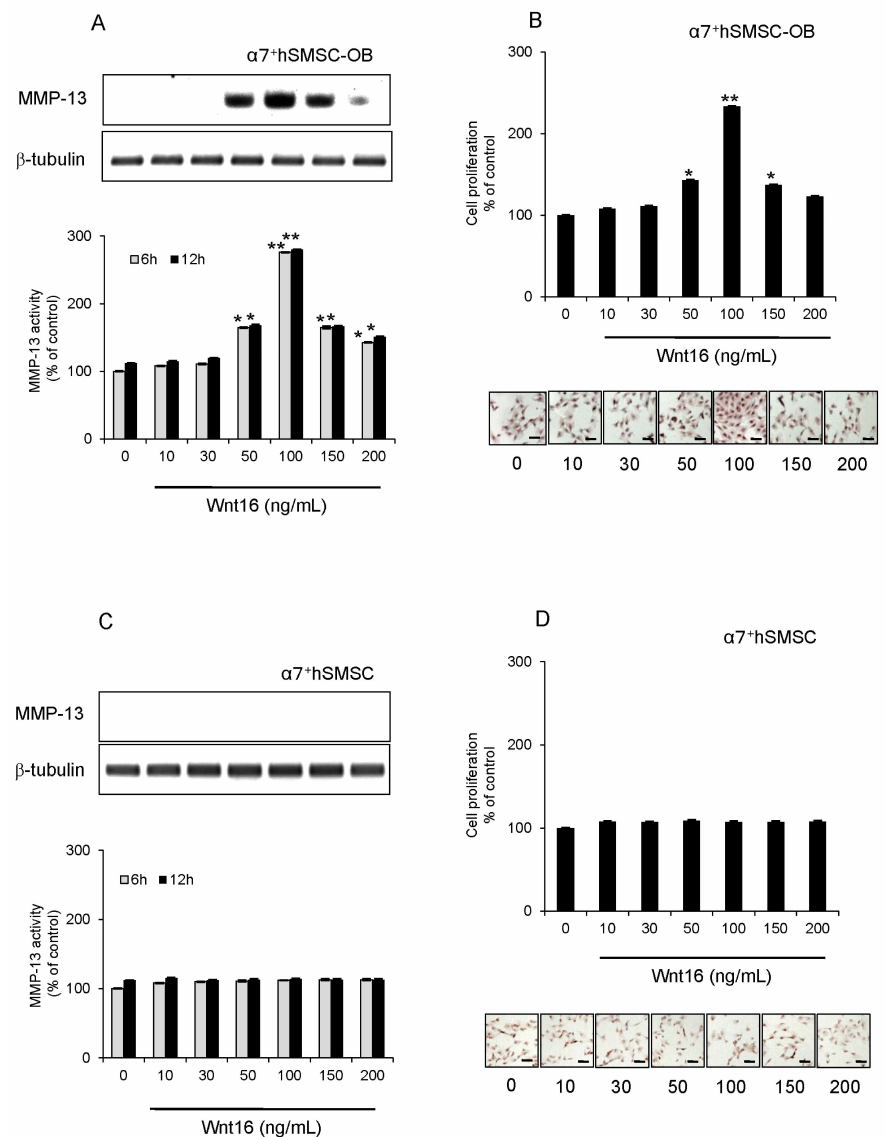
Figure 3. Effect of exogenous Wnt16 on MMP-13 expression and activity, and the proliferation of α 7 + hSMSC-OB cells. ( A , B ) Cells were treated for 6 h (grey bars) and 12 h (black bars) with 0, 10, 30, 50, 100, 150 and 200 ng/mL exogenous Wnt16 prior to analysis. Upper panels show Western blots of MMP-13 protein expression compared with β -tubulin levels. Blots are representative of three independent experiments; lower panels show MMP-13 activity. Data are the mean ˘ SD of four independent experiments * p < 0.05 and ** p < 0.01; ( C , D ) Effect of exogenous Wnt16 on cell proliferation. Cells were treated with Wnt16 (0, 10, 30, 50, 100, 150, and 200 ng/mL) for 24 h. Their proliferation status was then evaluated using the BrdU-cell proliferation ELISA (graphs) and BrdU immunohistochemistry kit (images; nuclei are stained brown in proliferating cells). Scale bars = 100 µ m. ELISA data are the mean ˘ SD of four independent experiments. * p < 0.05, ** p <